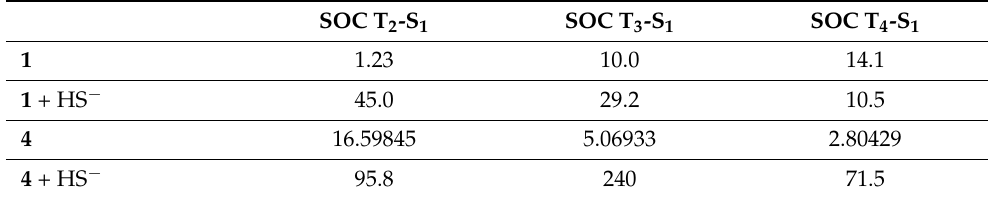
Table 2. Spin-Orbit coupling elements (cm − 1 ) for complex 1 , complex 4 and their adducts.